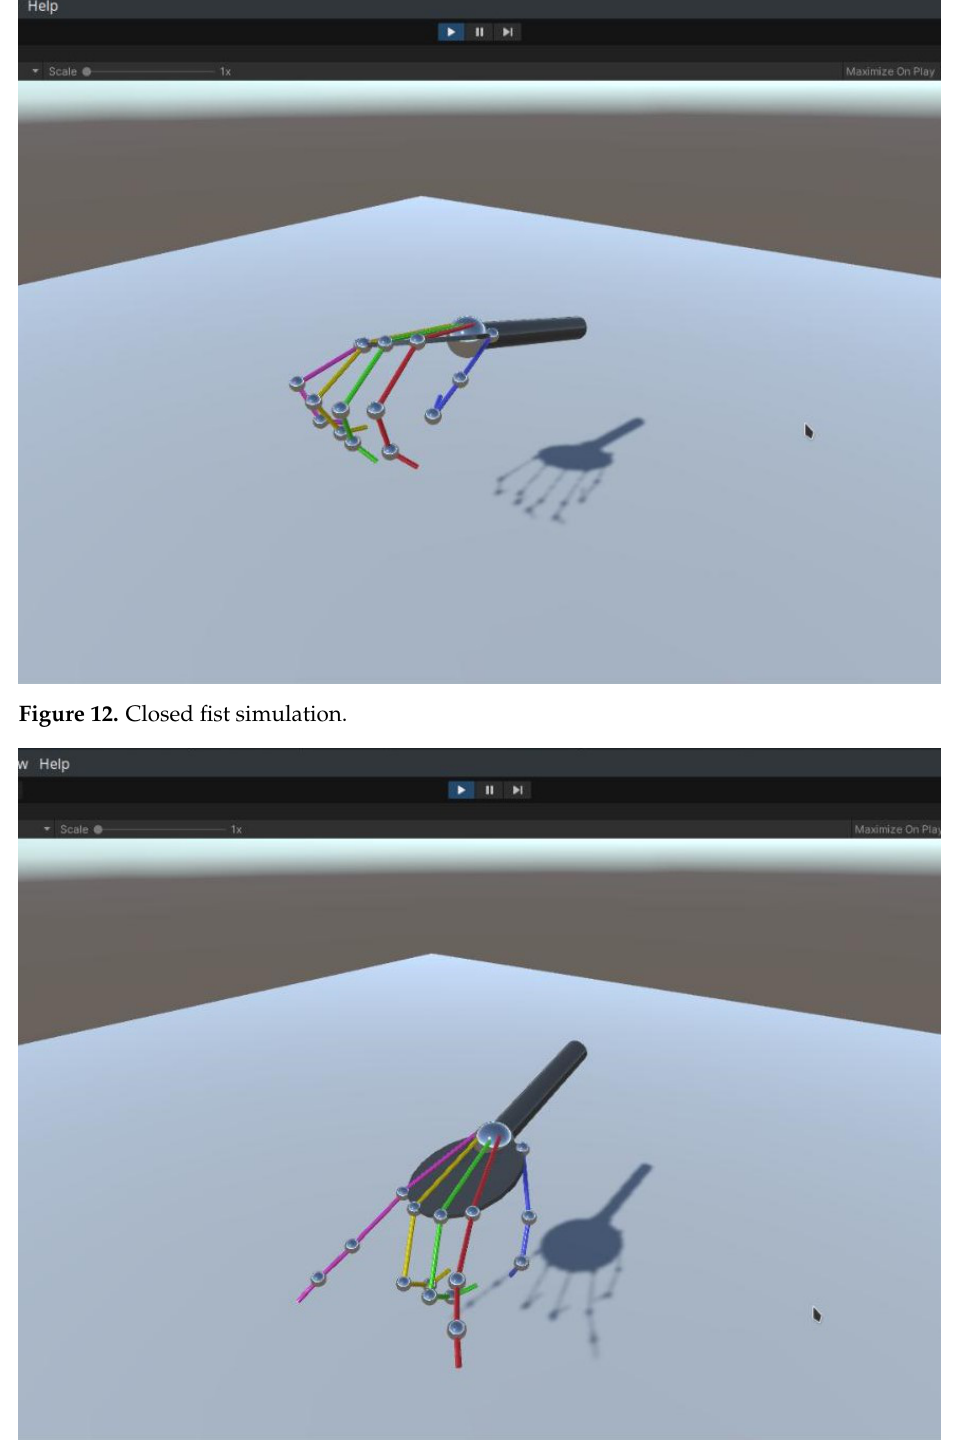
Figure 13. “Spiderman” hand